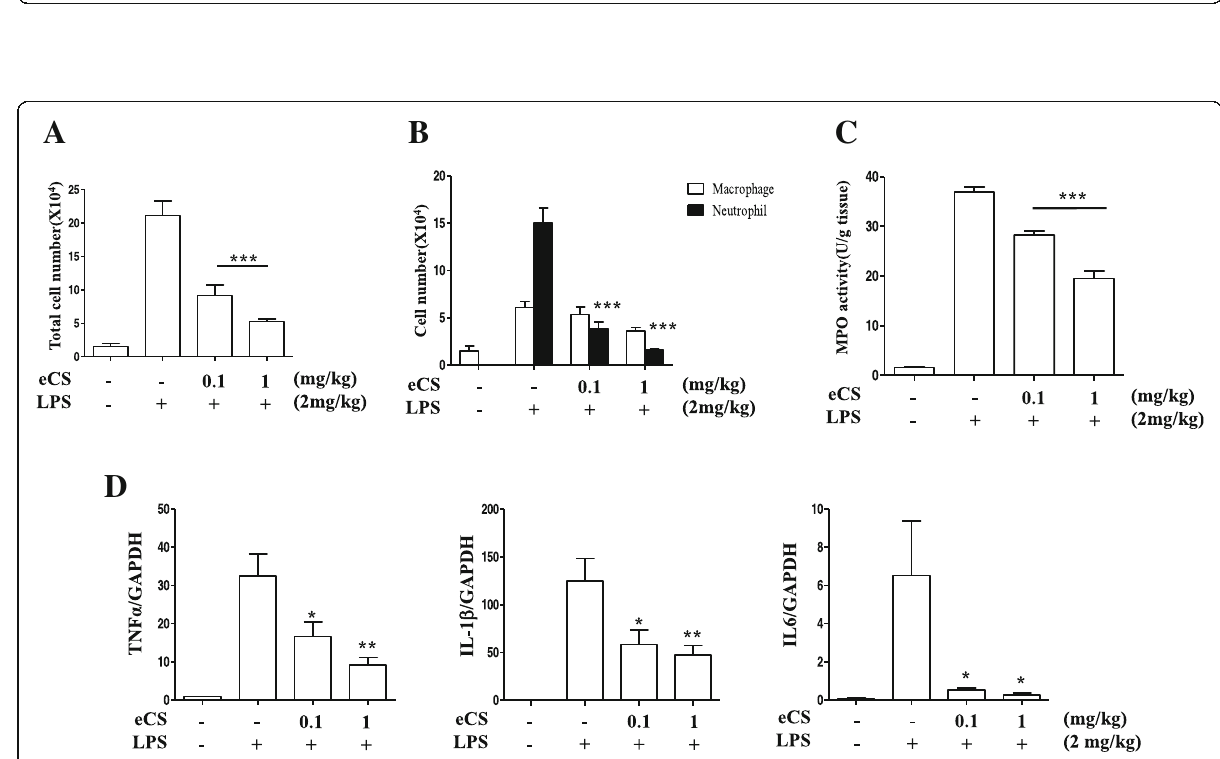
Fig. 6 The effect of intratracheal delivery of eCS on lung inflammation and the expression of Nrf2-dependent genes in an LPS-induced ALI mouse model. C57BL/6 mice ( n =5/group) received sham ( a ) or a single, 2mg/kg body weight of i.t. LPS ( b , c , and d ). At 2h after LPS treatment, mice received a single, 0.1mg/kg body weight of i.t. eCS ( c ) or 1mg/kg body weight of i.t. eCS ( d ). At 24h after LPS administration, the lungs of mice were harvested and stained with HE for histological examination. Data are representatives of at least five different areas of a lung (bar, 200× magnifications). e Total RNA extracted from the harvested lungs (n=5/group) was analyzed by semi-quantitative RT-PCR to assess expressions of NQO-1, HO-1, and GCLC. The intensity of each PCR band was measured by densitometric analysis (ImageJ) and normalized to GAPDH intensity. * P was less than 0.05, compared with the LPS treated (post-ANOVA comparison with Tukey ’ s post hoc test)